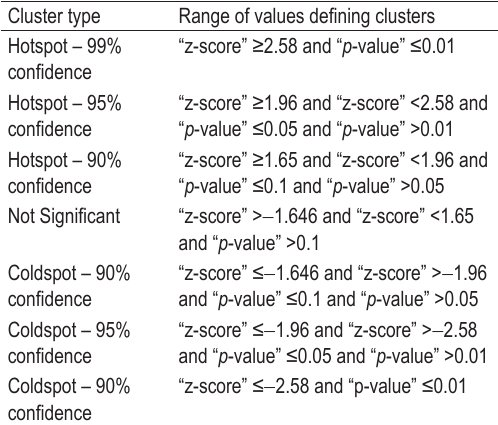
TABLE 2. Combination of z-score and p -values defining cluster types based on the Getis-Ord Gi* statistics analysis Cluster type